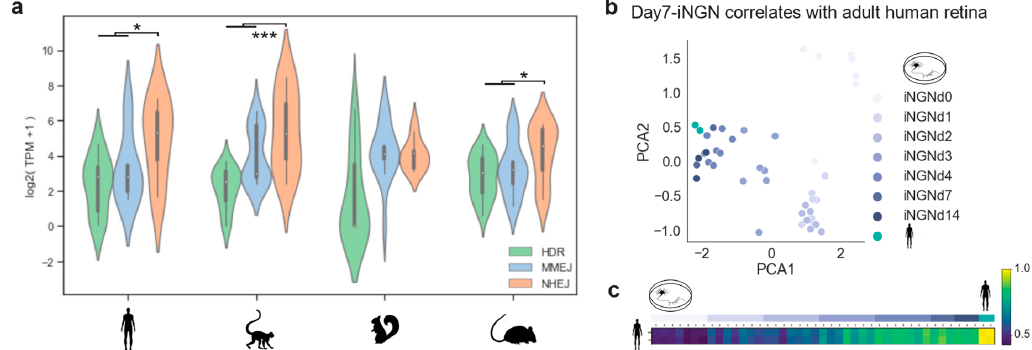
Figure 4. Cell-cycle-related genes correlate to DSB pathways . ( a ) Violin plot of gene expression abundance in DSB repair pathways in primates and rodents. Pairwise comparison significance was tested by Wilcoxon signed-rank test. ( b,c ) PCA plot and Spearman correlation of all sequencing replicates showing the relationship between DSB repair pathway genes in human retinas and developing in vitro